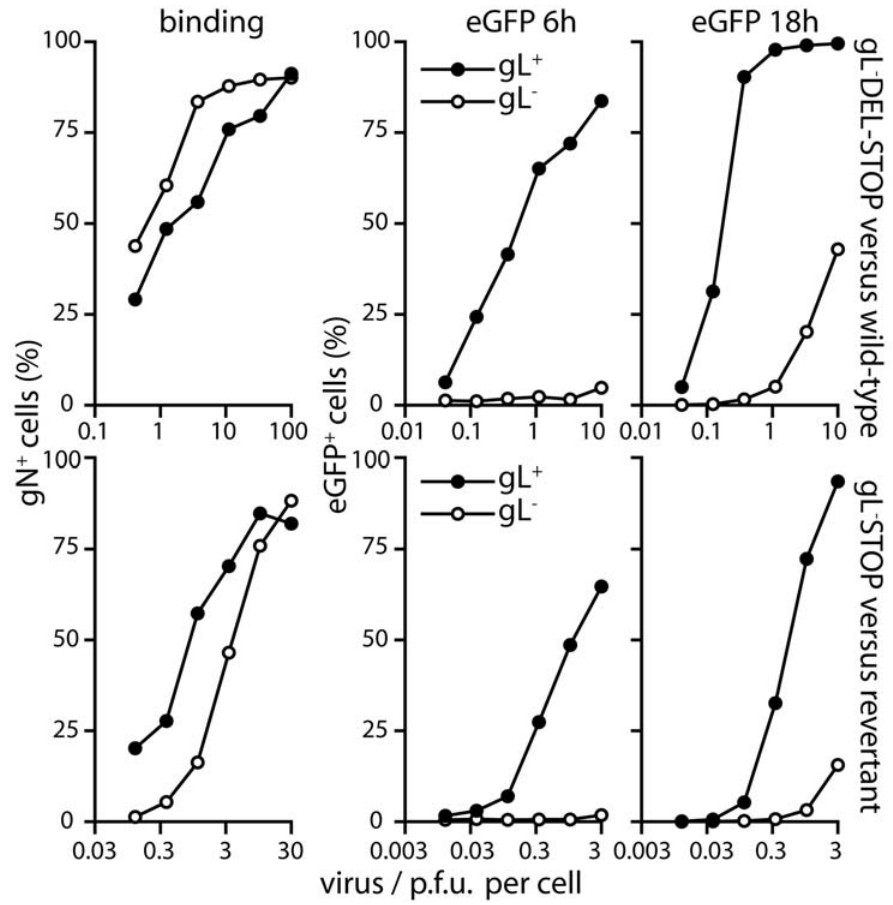
Figure 3. gL 2 virions show a post-binding deficit in NMuMG cell infection. NMuMG cells were exposed to gL + or gL 2 MuHV-4 virions (3 h, 37 u C), then washed 6 3 in PBS. Equivalent samples were then either fixed, permeabilized and stained for gN with mAb 3F7 to determine virion uptake by flow cytometry; or incubated for a further 3 h or 15 h, after which viral eGFP expression was assayed by flow cytometry of intact cells. Each point shows the result for 10,000 cells. Equivalent results - the infectivity of gL 2 viruses was , 1% that of gL + viruses for an equivalent level of cell binding - were obtained in a repeat experiment.